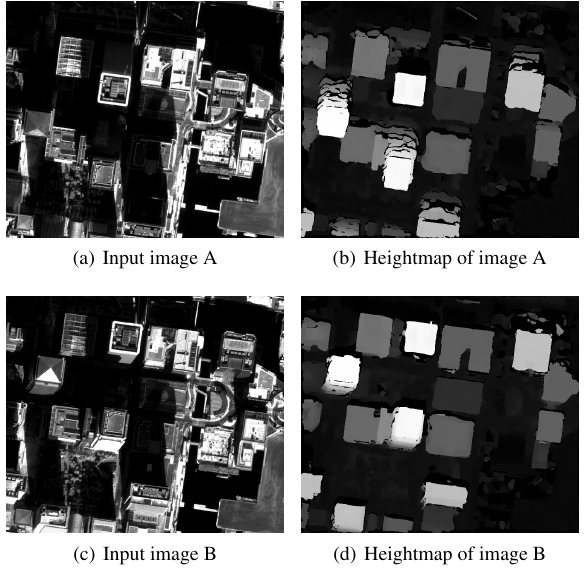
Figure 3: London dataset: 2 out of 10 input images and their corresponding heightmaps